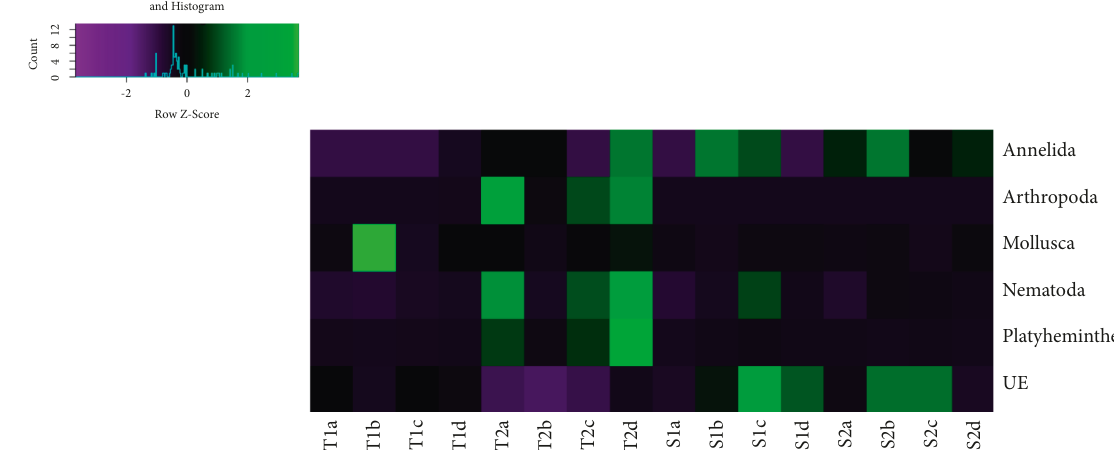
Figure 1: Soil invertebrate at the phylum level (relative abundance). T1a–d and T2a–d mean termite mounds from Braklaagte and Zeerust, respectively, while S1a–d and S2a–d mean adjacent soils from Braklaagte and Zeerust, respectively. UE � unclassified eukaryote. The relative abundance of the soil invertebrates was transformed with the z-score as expressed in colour saturation gradient seen in the scale bar.